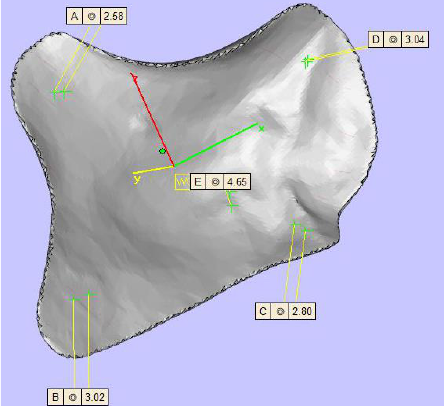
Figure 3. Display of the zygomatic implant design with five different thicknesses (top left 2.58 mm, top right 3.04 mm, center 4.65 mm, left bottom 3.02 mm, right bottom 2.80 mm).